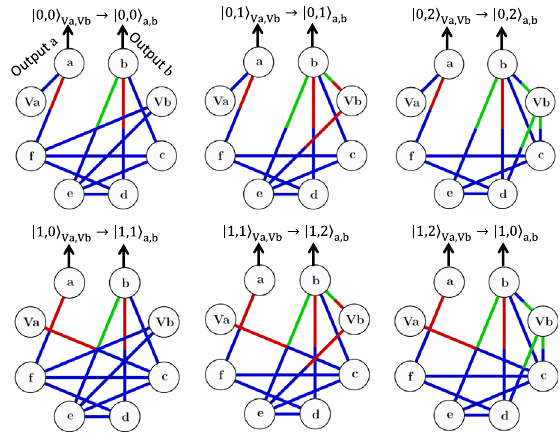
FIG. 10. High-dimensional CNOT gate, with a qubit control photon and a qutrit target